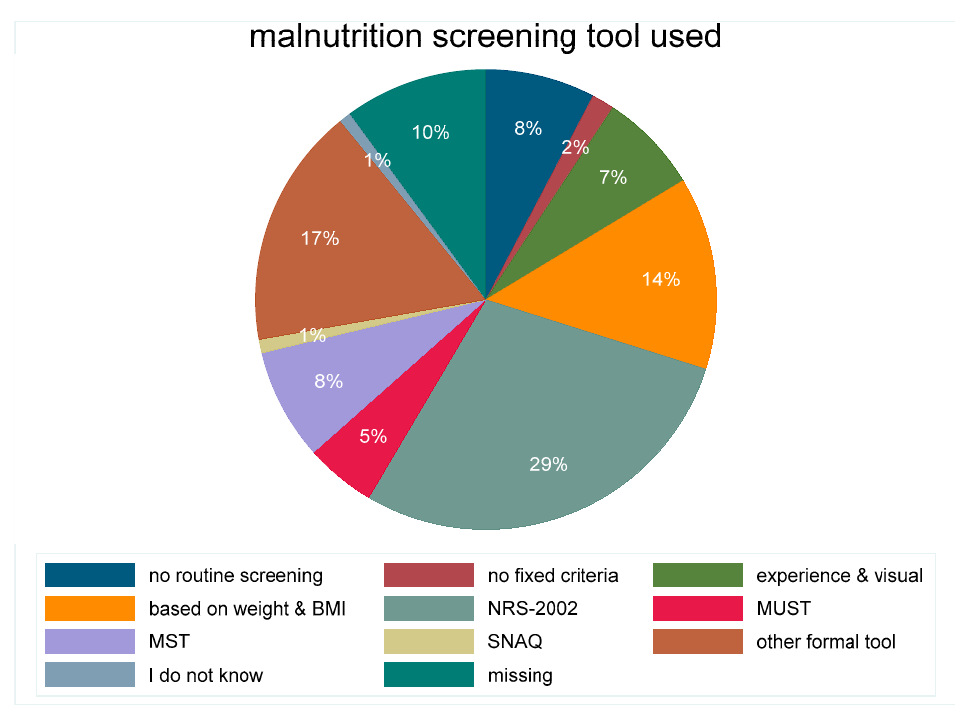
Figure 2. Proportion of different methods/approaches used for malnutrition screening in 1415 units from 46 countries in the nutritionDay cohort 2016–2018. NRS-2002 (nutrition risk screening 2002); MUST (Malnutrition Universal Screening Tool); MST (Malnutrition Screening Tool); SNAQ (Short Nutritional Assessment Questionnaire).